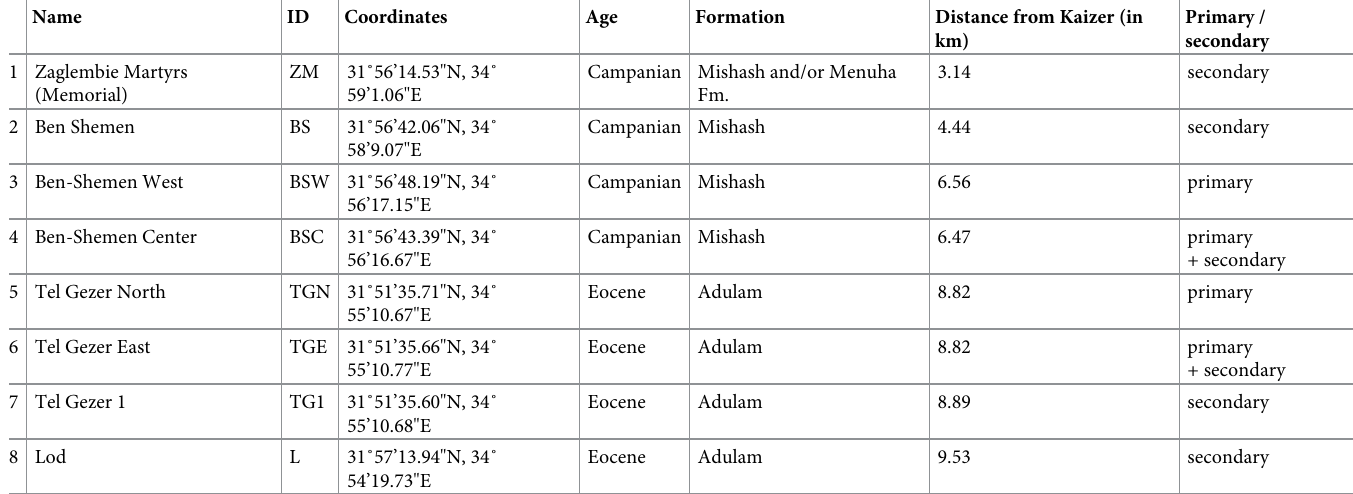
Table 1. The surveyed geologic sources.